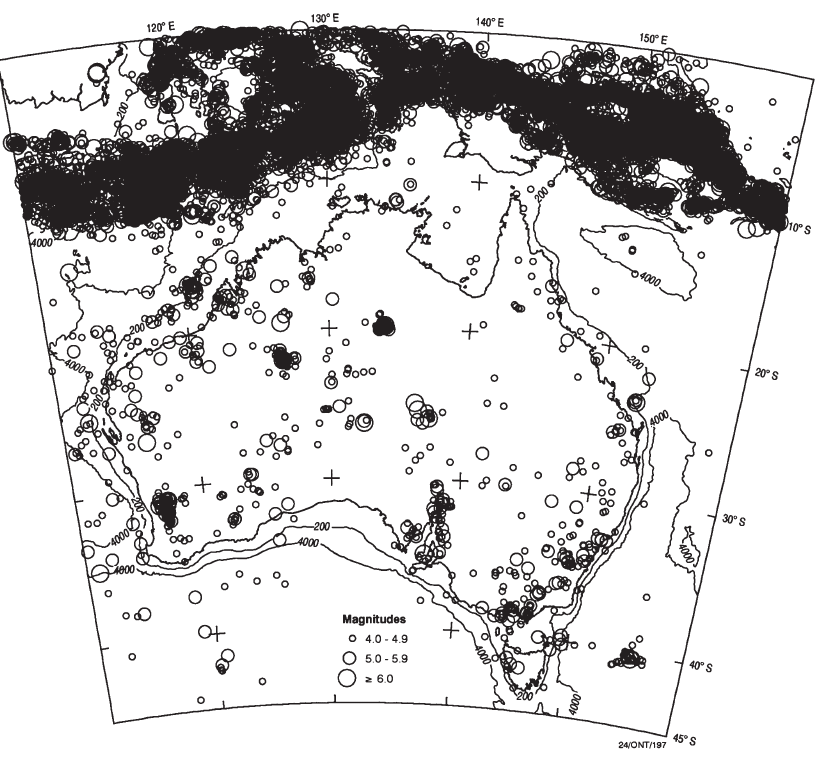
Fig. 2. Seismicity of Australia 1788 to 2000. The dot size is related to magnitude, the smallest magnitude 4, the largest magnitude